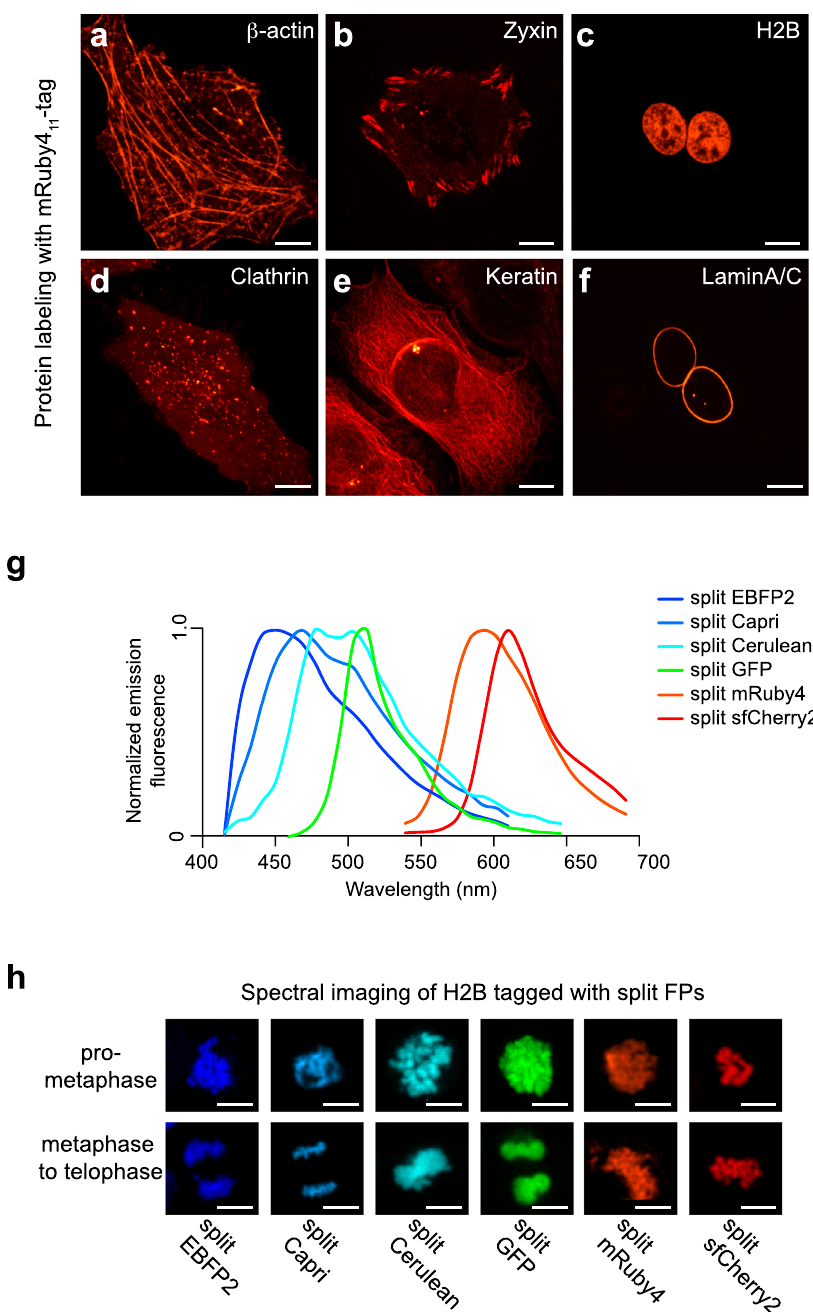
Fig. 2 Development of mRuby4, a new red-colored split FP. a – f Cells co-expressing mRuby4 1-10 with mRuby4 11 -fused cellular proteins. For each, the name of the fusion partner and its normal subcellular location are indicated, respectively; β -actin, actin stress fi bers ( a ); Zyxin, focal adhesion ( b ); histone 2B, nuclei ( c ), Clathrin light chain, clathrin-coated pits ( d ); Keratin, intermediate fi laments ( e ); Lamin A/C, nuclear envelops ( f ). g Normalized fl uorescence emission spectra of FP 1-10/11 variants in HeLa cells. ( h ) HEK 293 cells expressing H2B labeled with EBFP2 1-10/11 , Capri 1-10/11 , Cerulean 1-10/11 , GFP 1-10/11 , mRuby4 1-10/11 , or sfCherry2 1-10/11 were co-cultured in the same plate. Spectrally unmixed images at the different stages of mitosis are represented (see also Supplementary Fig. 14). Scale bars,10 μ